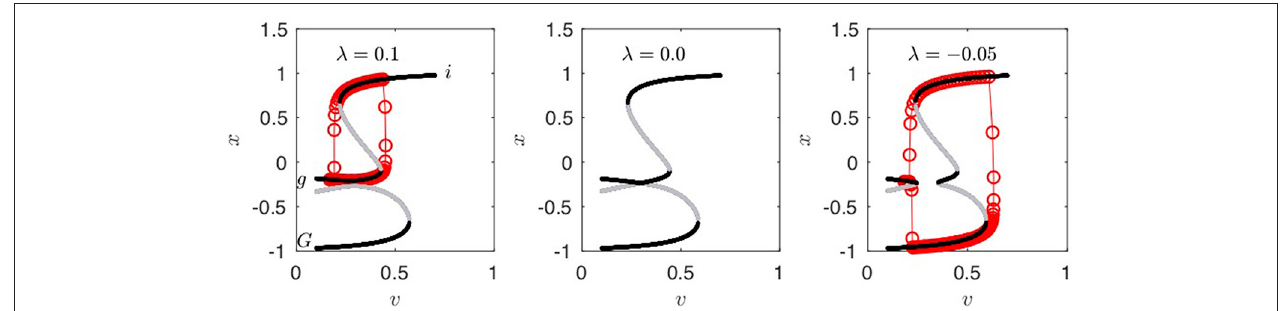
FIGURE 11 | The parameter λ determines the bifurcation structure of the model (7). For λ = 0.1 the deep glacial state G is separated from the interglacial state i and the mild glacial state g (left panel). The red curve is the trajectory with the insolation I ( t ) = A cos ω F t , A = 0.016 and ω F = 2 π/ 41. The fast-slow hysteresis loop is i → g → i . As λ decreases the system goes through a transcritical bifurcation for λ = 0 (middle panel). There is also a cusp bifurcation of the slow manifold (not shown) on reducing λ further. For λ < 0 the state G becomes accessible and the fast-slow system moves through the hysteresis loop i → g → G → i .